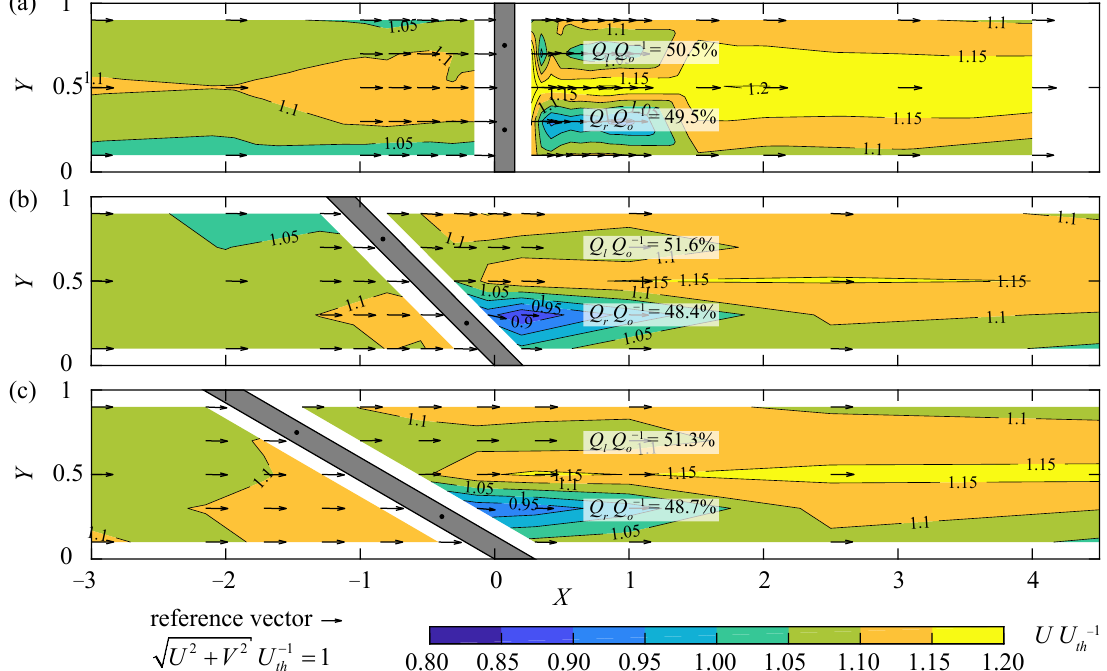
Figure 6. Velocity field at Z = 0.5 for S2, s b = 20 mm, and H Ov = 0 for ( a ) α = 90 ◦ ( ξ R = 0.43), ( b ) α = 45 ◦